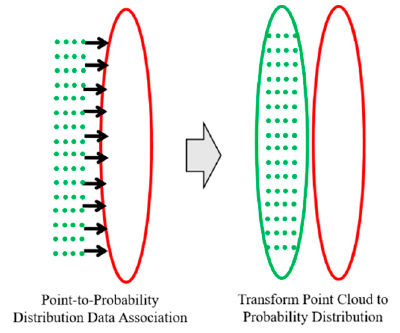
Figure 24. Example of point cloud to probability distribution conversion.